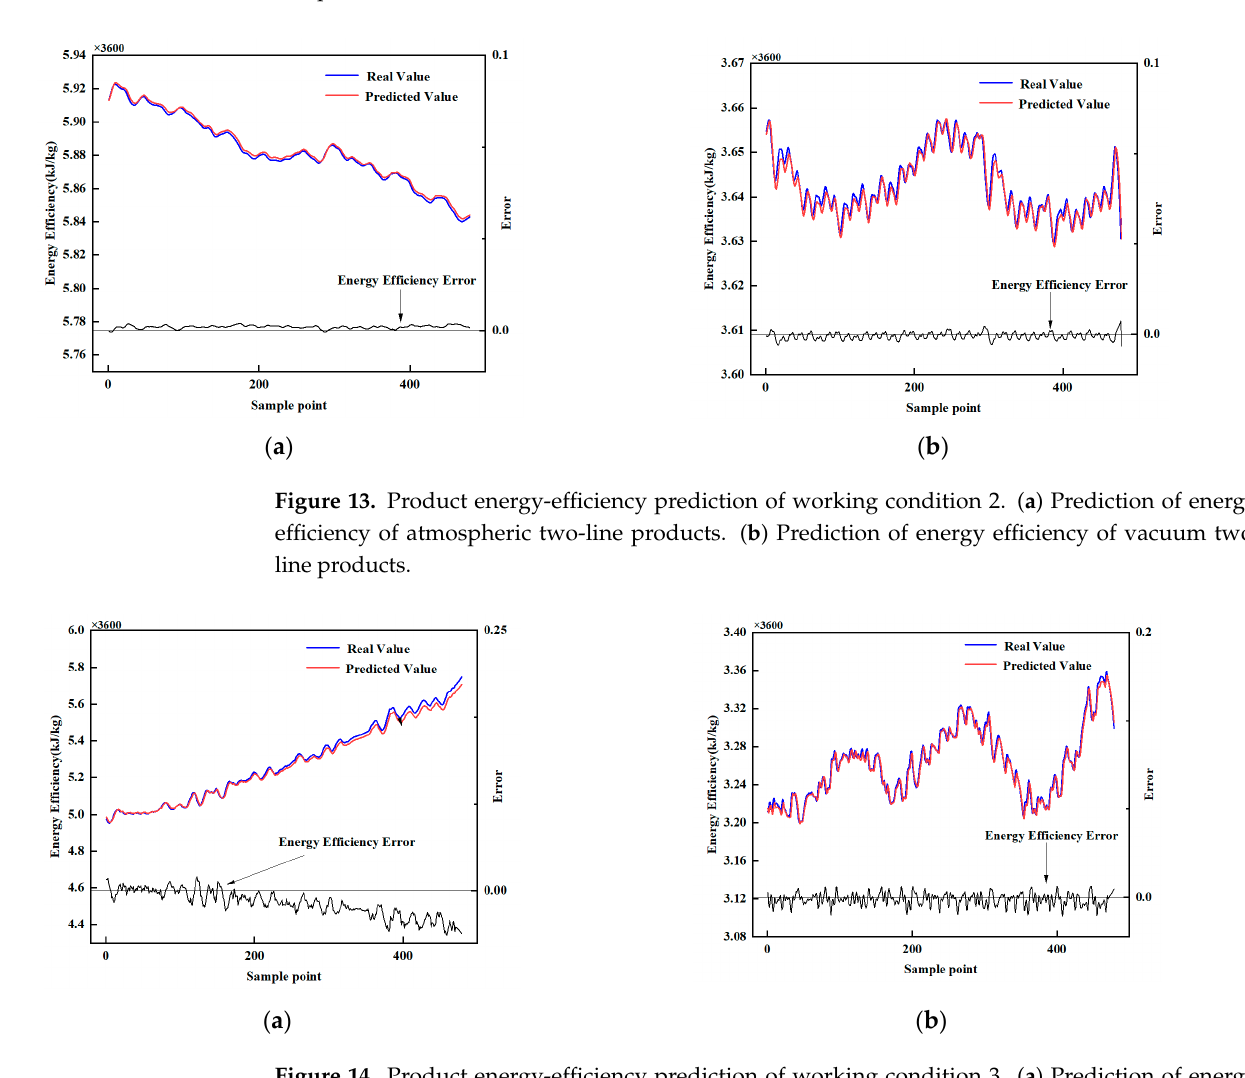
( b ) Figure 15. Product energy-efficiency prediction of working condition 4. ( a ) Prediction of energy ef- ficiency of atmospheric two-line products. ( b ) Prediction of energy efficiency of vacuum two-line products. In order to better evaluate the prediction accuracy of the LSTM model, MAPE, MAE, and MSE of the LSTM model under different working conditions are calculated and shown in Table 13. It can be seen that the values of MAE, MSE, and MAPE are lower than 1.3872%, 0.0307%, and 0.2555%, which proves the high accuracy of prediction results of energy efficiency. Table 13. The evaluation criterion of the LSTM model. Evaluation Criterion